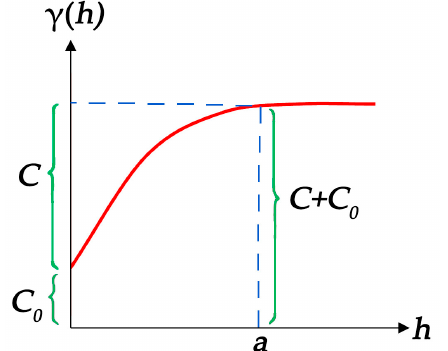
Figure 3. A diagram of the semi-variogram.